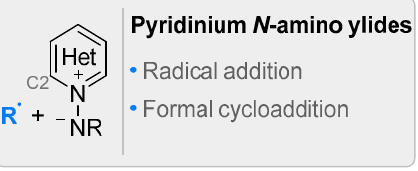
Figure 6. Radical-based transformations of pyridinium N -amino ylides.